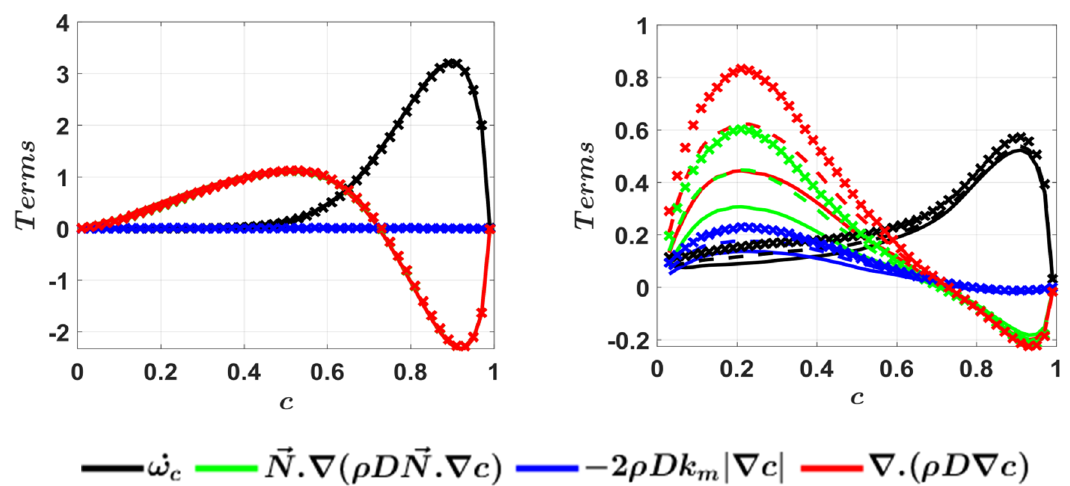
Figure 9. Profiles of the mean values of {(cid:2033)̇ (cid:3030) , (cid:1840)(cid:4652)(cid:4652)⃗ ∙ ∇(cid:3435)(cid:2025)(cid:1830)(cid:1840)(cid:4652)(cid:4652)⃗ ∙ ∇(cid:1855)(cid:3439),∇ ∙ ((cid:2025)(cid:1830) ∇(cid:1855)),−2(cid:2025)(cid:1830)(cid:2018) (cid:3040) |∇(cid:1855)| } × (cid:2012) (cid:3047)(cid:3035) /(cid:2025) (cid:3048) (cid:1845) (cid:3013) conditioned upon (cid:1855) for u (cid:48) / S L = 4.0 (solid line) 6.0 (broken line) and 8.0 (cross marker) for statistically planar turbulent premixed flames (first column) and homogeneous MILD combustion cases (second column). Note the difference in scales between premixed flame and MILD combustion cases.